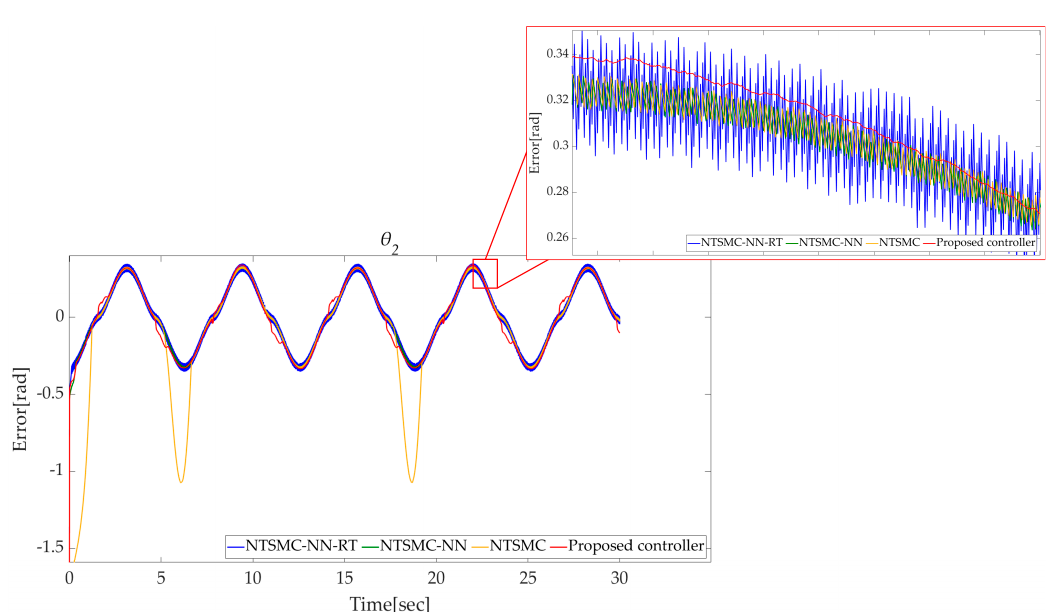
Figure 15. Comparing 𝜃 (cid:2870) error for continuous input.